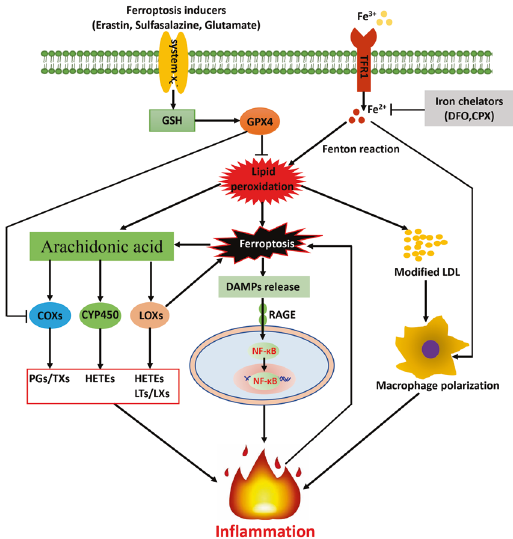
Fig. 2 Cross-talk between ferroptosis and in fl ammation. ROS- induced oxidative stress exacerbates the production of lipid peroxidation (LPO). LPO-induced ferroptotic cell death results in the release of damage-associated molecular patterns (DAMPs) from dying cells, which may promote sterile in fl ammation through the receptor for advanced glycation end products (RAGE) to activate NF- κ B. On the other hand, lipid peroxidation induced the increase in modi fi ed LDL partially contributes to in fl ammation activation via macrophage polarization. GPX4, the core regulator of ferroptosis, its activation suppressed ferroptosis and in fl ammatory responses via inhibiting arachidonic acid (AA) oxidation and NF- κ B pathway activation. Moreover, GPX4 can up-regulate the expression of 12- lipoxygenase and cyclooxygenase 1 (COX1) that trigger in fl amma- tory responses. AA, an unsaturated fatty acid and released from the cell membrane in response to various cytokines, peptides, and growth factors, that can be metabolized by cyclooxygenases (COXs), lipoxygenase (LOX), and cytochrome P450 (CYP450) monooxy- genases to synthesize bioactive proin fl ammatory mediators such as prostaglandins (PGs), leukotrienes (LTs), lipoxins (LXs), hydro- xyeicosatetraenoic acids (HETE) and hydroperoxyeicosatetraenoic acids (HPETE) that promote in fl ammatory responses. Finally, another vital regulator of ferroptosis, iron also participates the regulation of immune system via modulating M1 macrophage